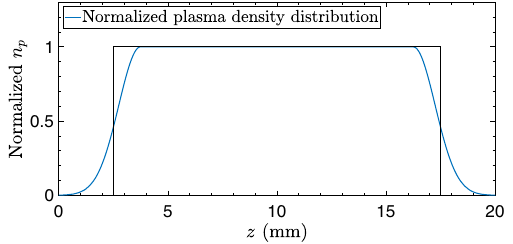
FIG. 2. Normalized plasma density distribution along the APL. The black solid line represents the active focusing gradient, which is assumed to be constant within the lens. We note that in the time scale of proton and electron beam passages, discharge current in the APL can be regarded as stationary